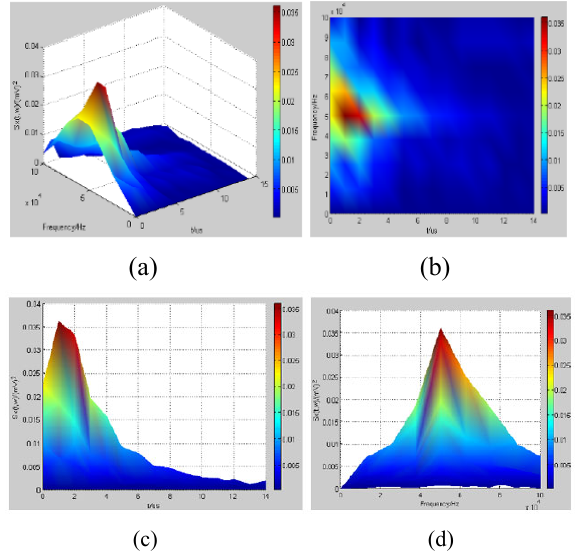
Fig. 9 Micro plasma shock wave acoustic emission signal time-frequency distribution by femtosecond laser ablation of aluminium iron copper alloy (93:2:5): (a) graphic model, (b) plan view ( x - y ), (c) front view ( x - z ), and (d) side view ( y - z